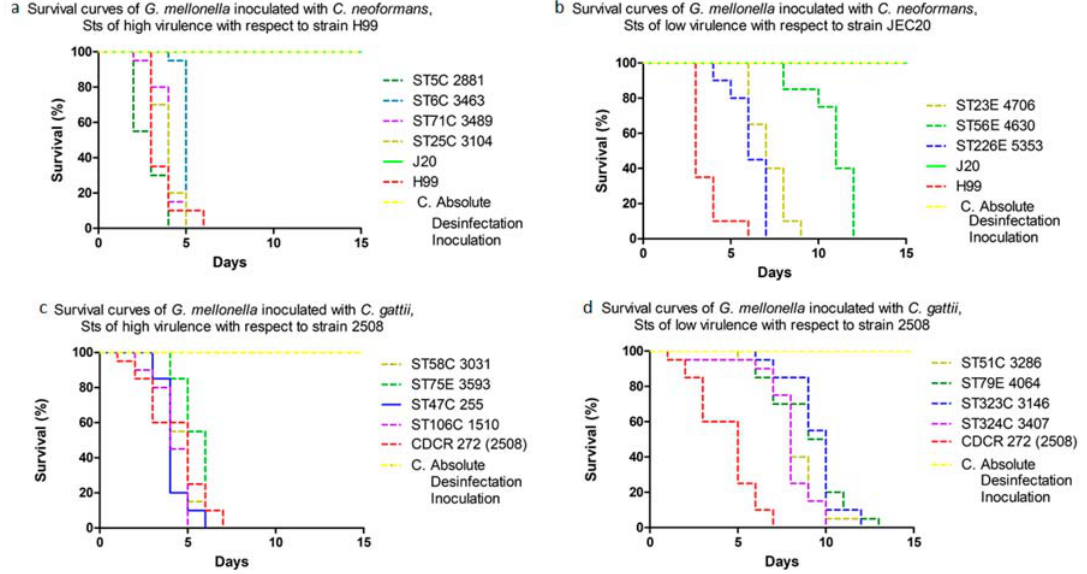
Figure 1. Survival curves of Galleria mellonella inoculated with Colombian isolates of the Cryptococcus neoformans species complex ( a , b ) and Cryptococcus gattii species complex ( c , d ).